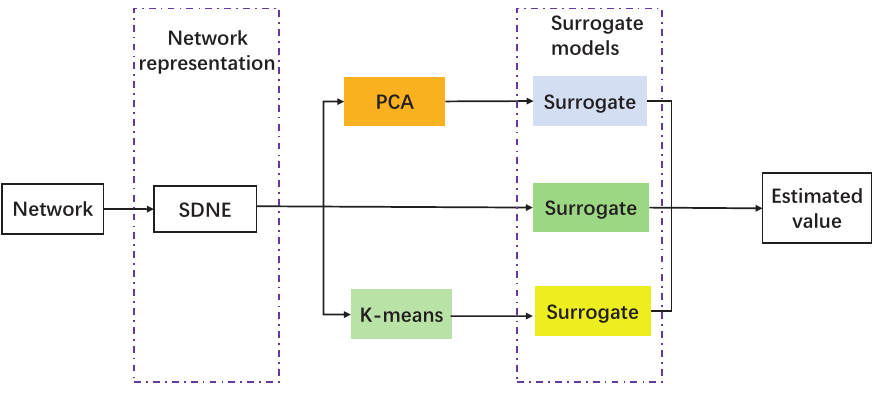
Figure 1. The structure of the surrogate ensemble for estimating network